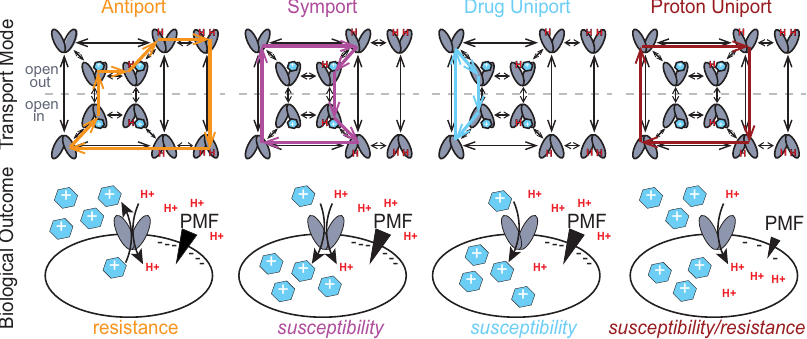
Fig. 1 | Different transport modes of EmrE result in different biological out- comes. The well-established coupled antiportof proton and drug (orange, top)by EmrE leads to drug resistance in vivo (orange, bottom). The Free Exchange Model suggests that EmrE should also be able to perform coupled symport (purple), or drug uniport (blue), either of which would lead to susceptibility rather than resis- tance in vivo. Proton uniport (maroon) will dissipate Δ pH and could lead to either